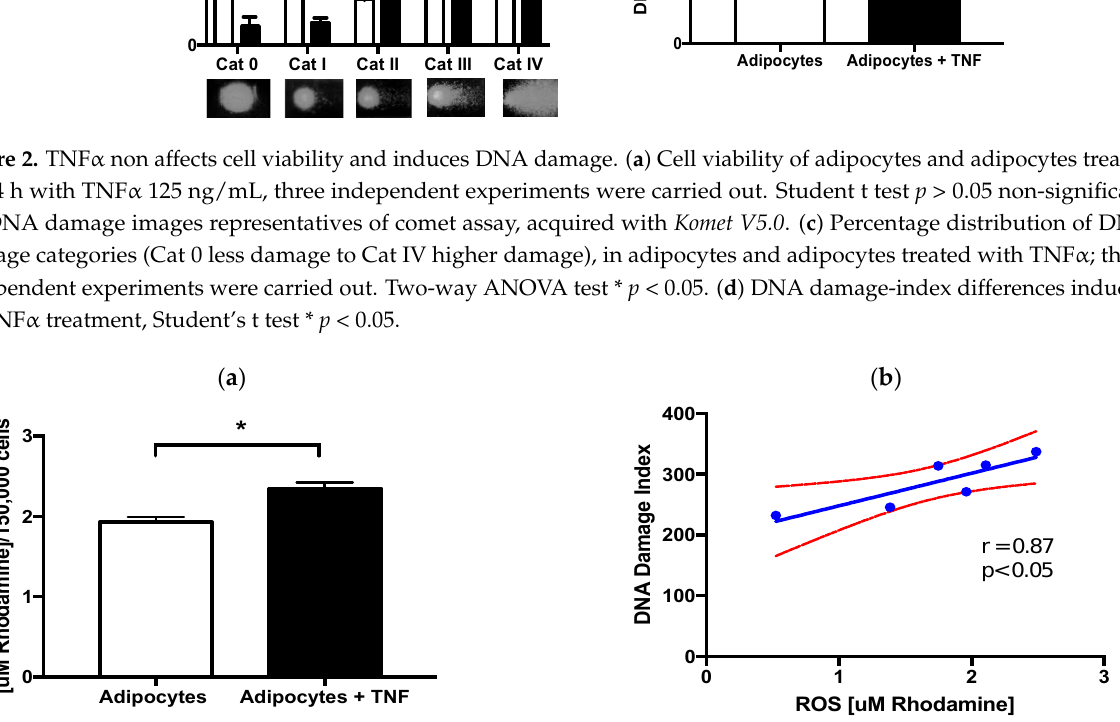
Figure 3. ROS and DNA damage. ( a ) Intracellular ROS levels induced by TNF α treatment (24 h, 125 ng/mL) in newly differentiated adipocytes, three independent experiments with experimental replicate were carried out. Student’s t test *